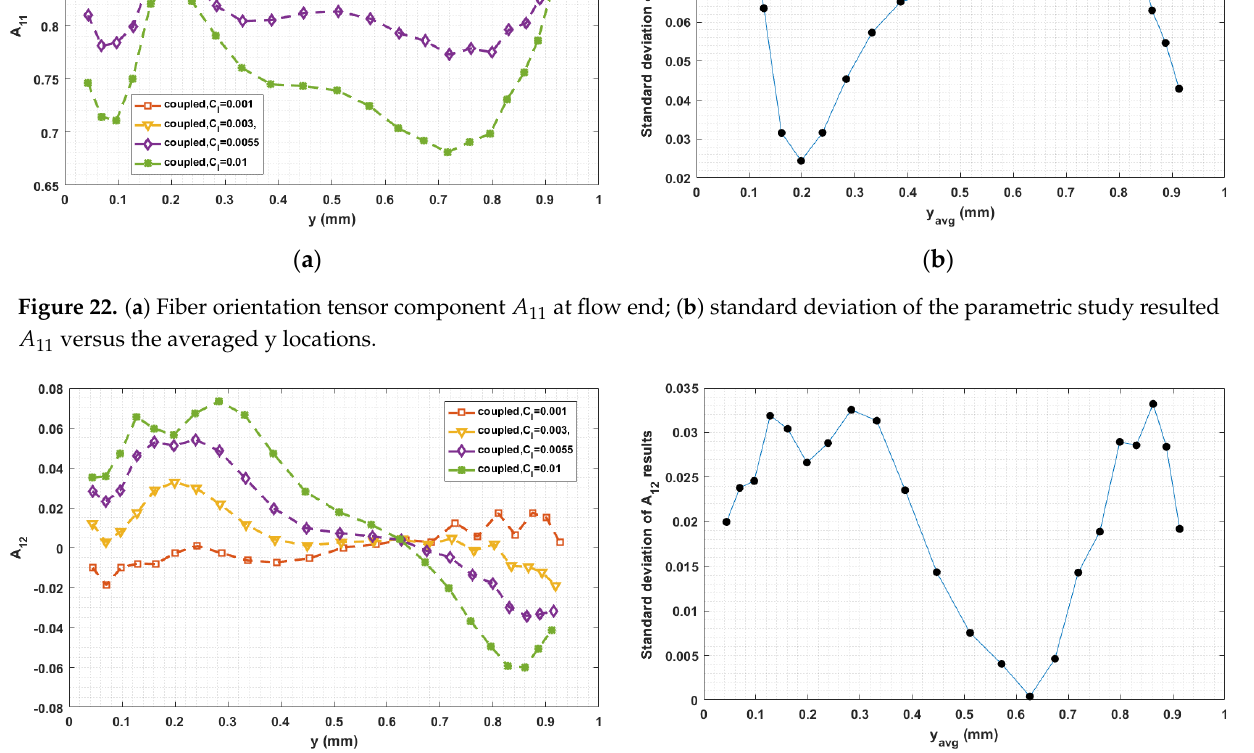
Figure 23. ( a ) Fiber orientation tensor component A 12 at flow end; ( b ) standard deviation of the parametric study resulted A 12 versus the averaged y locations.